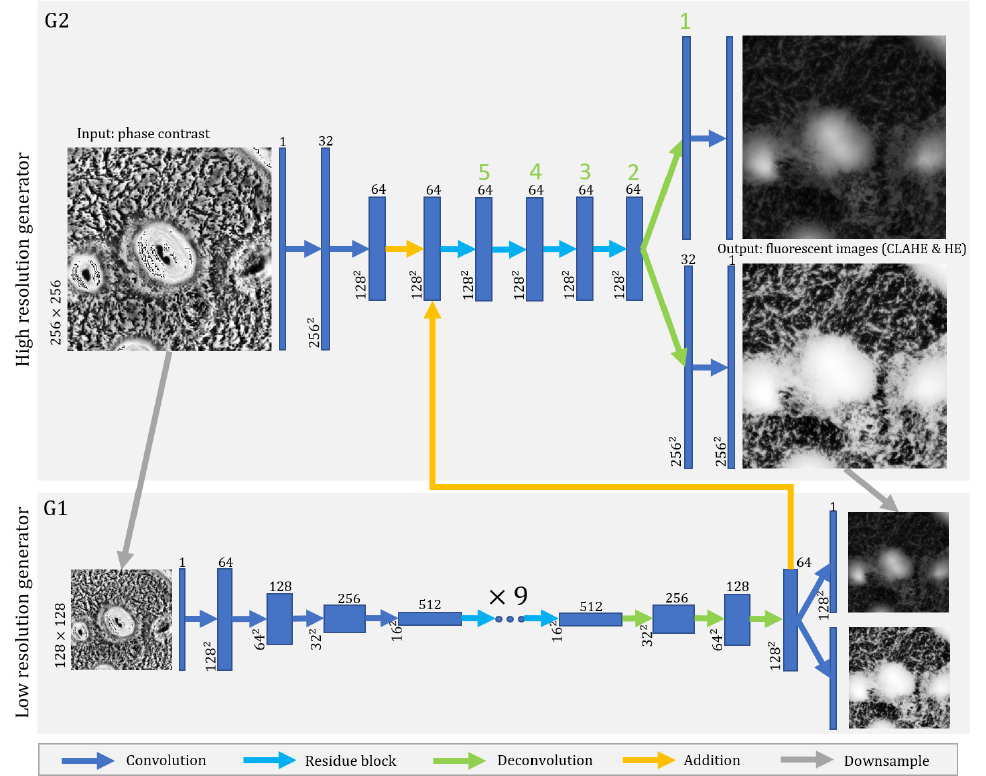
Figure 2. Network architecture of pix2pixHD-HE generator. The lengths and widths of the feature maps are annotated on the left. The depths of the feature maps are annotated as superscripts. The blue dots represent several 2-layer residual building blocks, above which the numbers of blocks are annotated. Each arrow represents an feed-forward operation step. The green numbers label the branch point, and No. 2 branch point produced the best performance (Supplementary Materials 1.2.4). We train the model as described in [28]. We use 2 discriminators to separately discriminate the normalized (CLAHE) and histogram-equalized (HE) fluorescent image